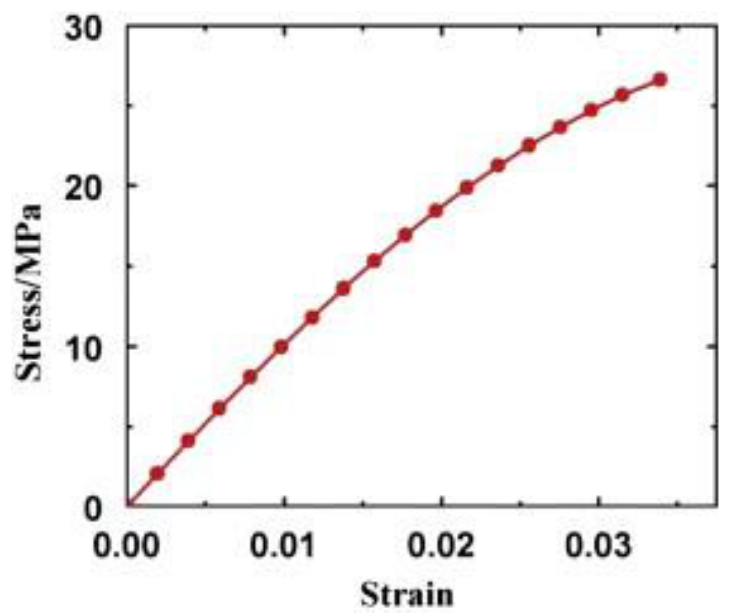
Figure 6. Stress–strain curve of an MWCNT film obtained by the digital speckle correlation method [73]. Used with permission from Elsevier.